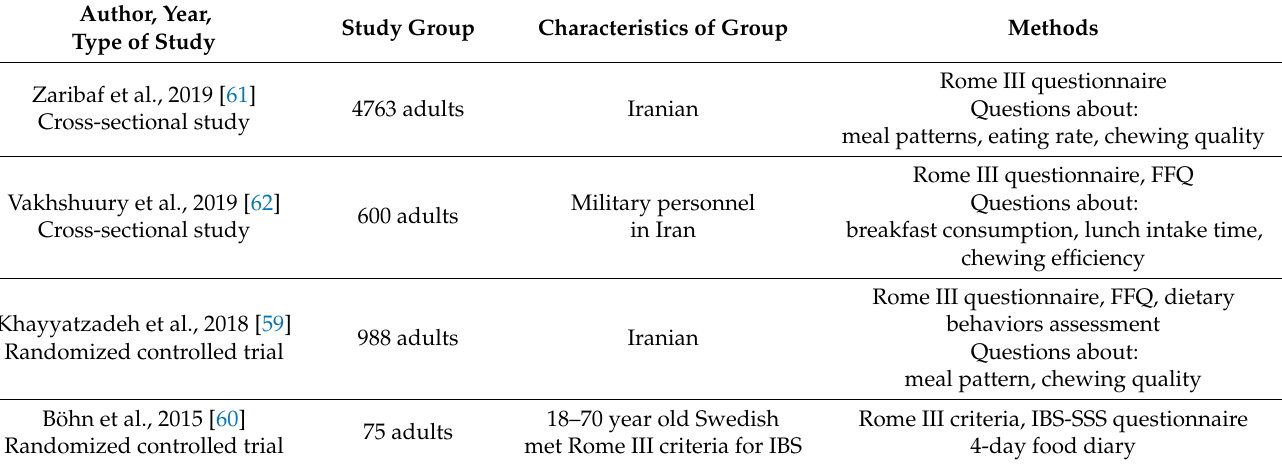
Table 5. Characteristics of included studies connected with mindful